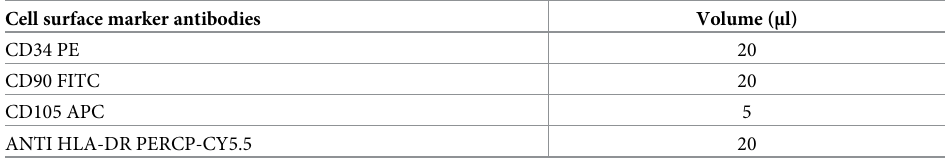
Table 1. List of antibodies used for cell surface markers